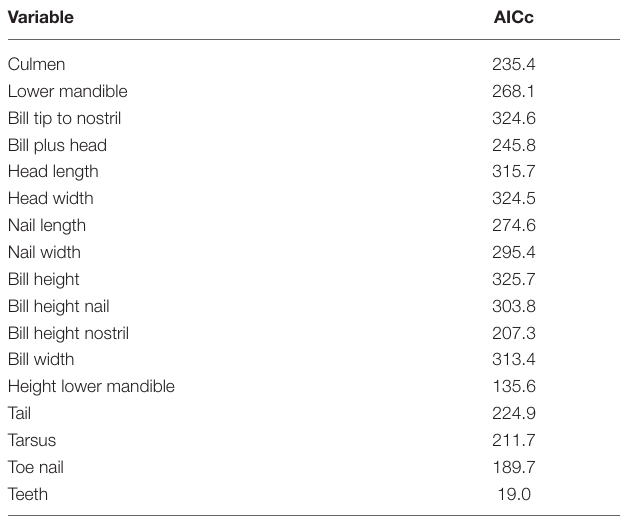
TABLE 4 | AICc scores for all 17 single variable logistic models.